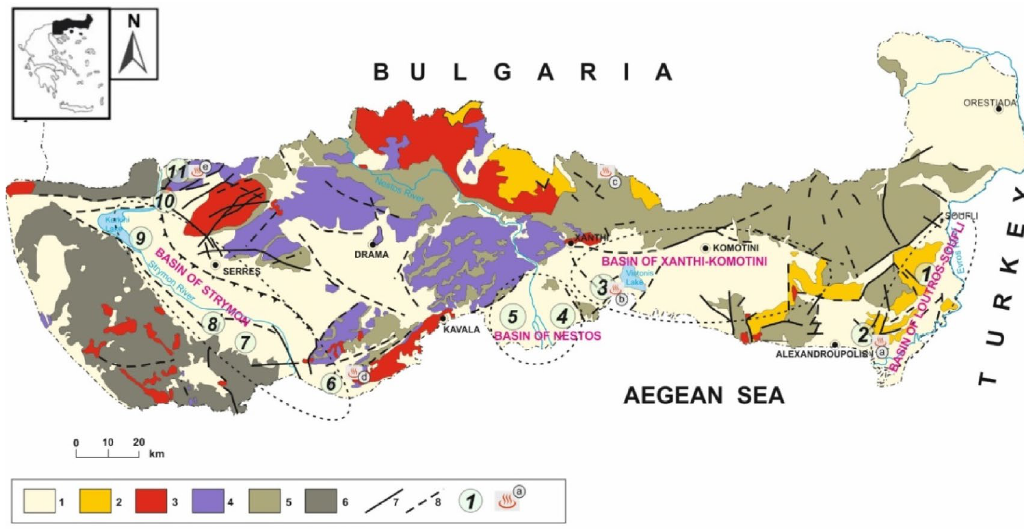
Figure 1. Tertiary sedimentary basins and investigated low temperature geothermal fields located on a simplified geotectonic map of North Eastern Greece (scale 1:500.000 4